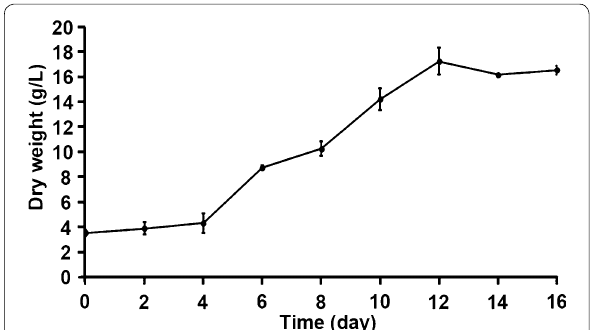
Fig. 1 The growth curve measurement in grapevine cell cultures. Growth of cells in flask culture was measured at different time points. Three replications were performed for each sample. The maximum biomass growth was achieved on day 12 of grapevine cell